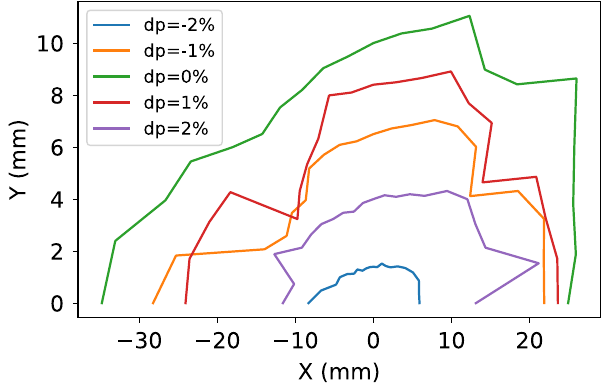
FIG. 15. Optimized on- and off-momentum dynamic apertures for the off-resonance scheme as listed in Table